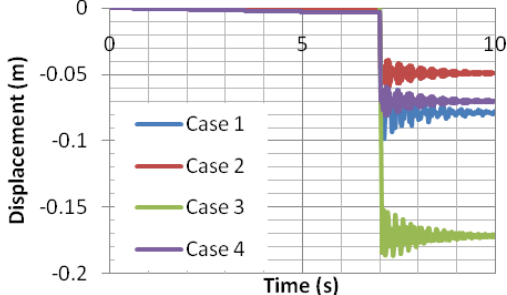
Fig. 10. Vertical displacements of column removal point in 5-storey